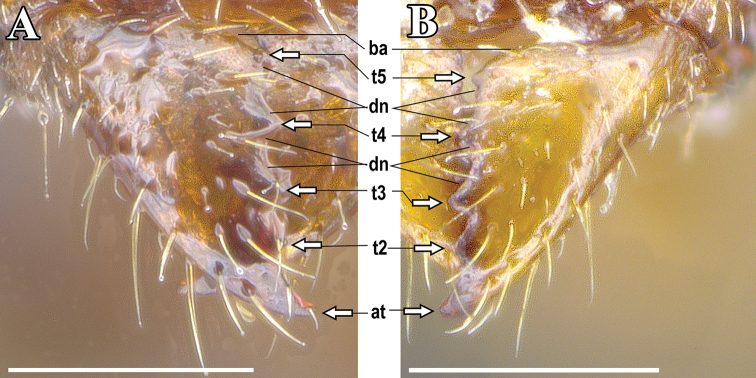
Mandible of Ponera
tudigong sp. nov. A Queen (ANTWEB1009670) B worker (ANTWEB1009796). Abbreviations: ba: basal angle of mandible; t: tooth number; at: apical tooth of mandible; dn: denticle; sensu Bolton (1994).